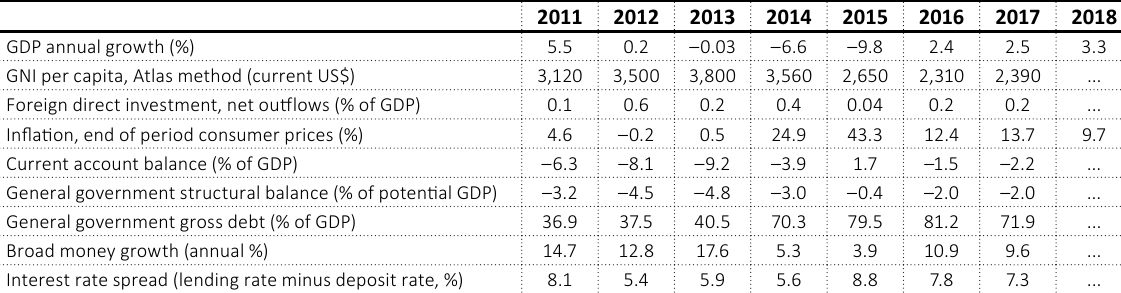
Table 4. Macroeconomic development indicators of Ukraine in the post-crisis period